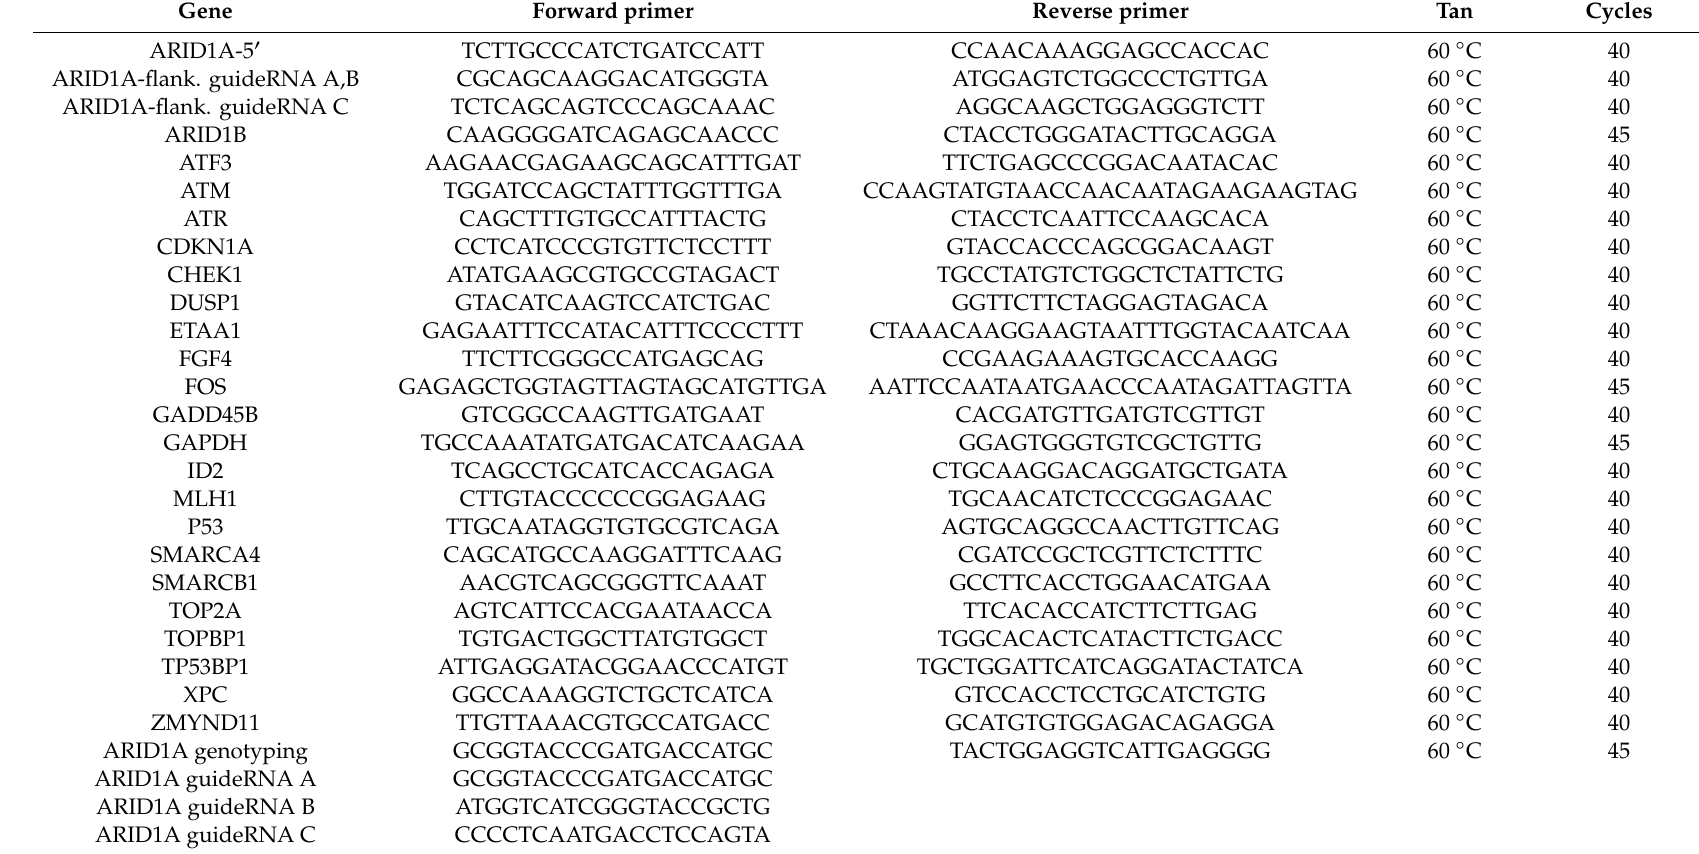
Table 1. Oligonucleotides used in this